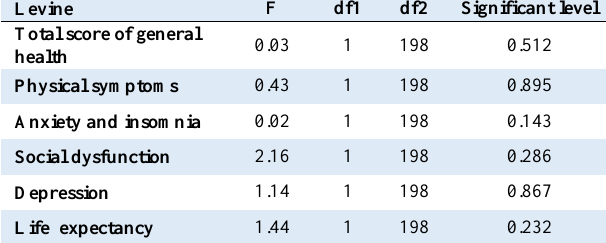
Table 2. Results of error variances homogeneity (Levine Test)